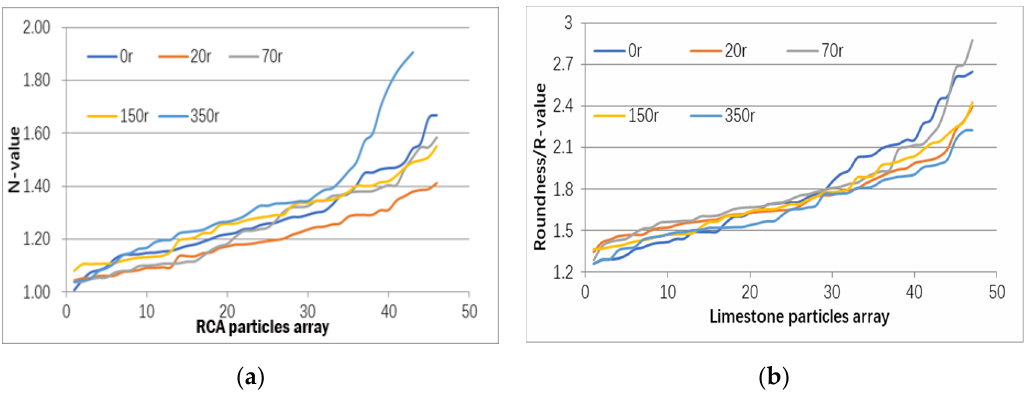
Figure 12. R-value variation of ( a ) RCA and ( b ) nature aggregates under surface treatment.